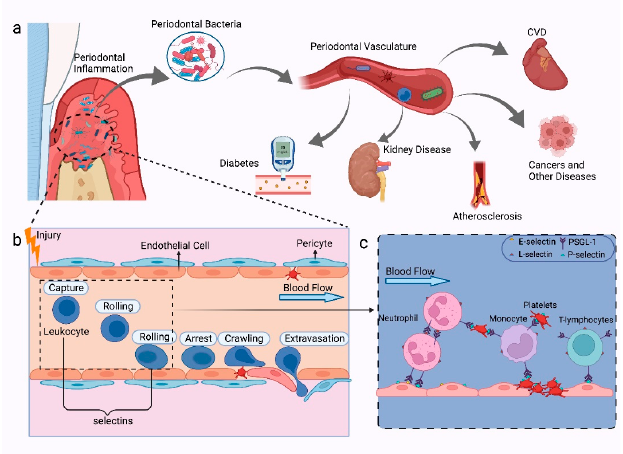
Figure 3. The mechanisms of selectins in periodontal diseases and systemic diseases. ( a ) Periodontal diseases caused by subgingival bacteria on the tooth surface and periodontal pocket. Periodontal bacteria can enter the bloodstream and cause systemic inflammation due to disruption in the integrity of the vascular endothelium, such as CVD, diabetes, kidney diseases, atherosclerosis, and certain cancers. ( b ) In a severe inflammation state, the host’s immune response will be triggered, which causes the activation of various lymphocytes in the vasculature, rolling of leukocytes on the vascular endothelium, spillover, and activation of platelets. ( c ) P-selectin is selectively expressed on activated platelets which connect platelet adhesion and leukocytes, such as neutrophils, monocytes, and T-lymphocytes; E-selectin and P-selectin are generally expressed on endothelial cells that activate the process of rolling of leukocytes; L-selectin is mainly expressed on leukocytes, which can mediate the recirculation of lymphoid cells and leukocytes adhesion; PSGL-1 can interact with P-, L-, and E-selectin, which can be expressed on platelets, neutrophils, monocytes, and most peripheral T cells and B cells. Figure created with